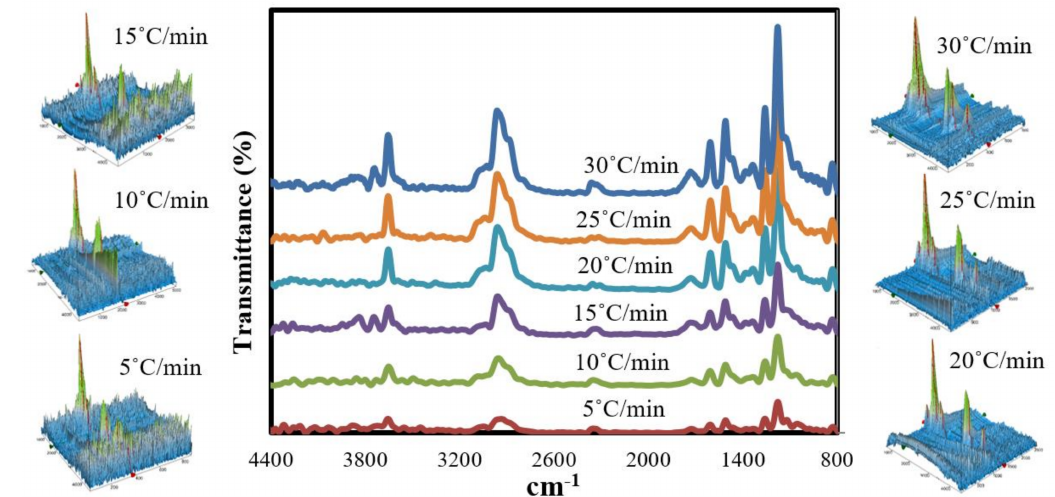
Figure 4. Two-dimensional (2D)-3D FTIR analysis of the decomposed milled GFRP at different heating